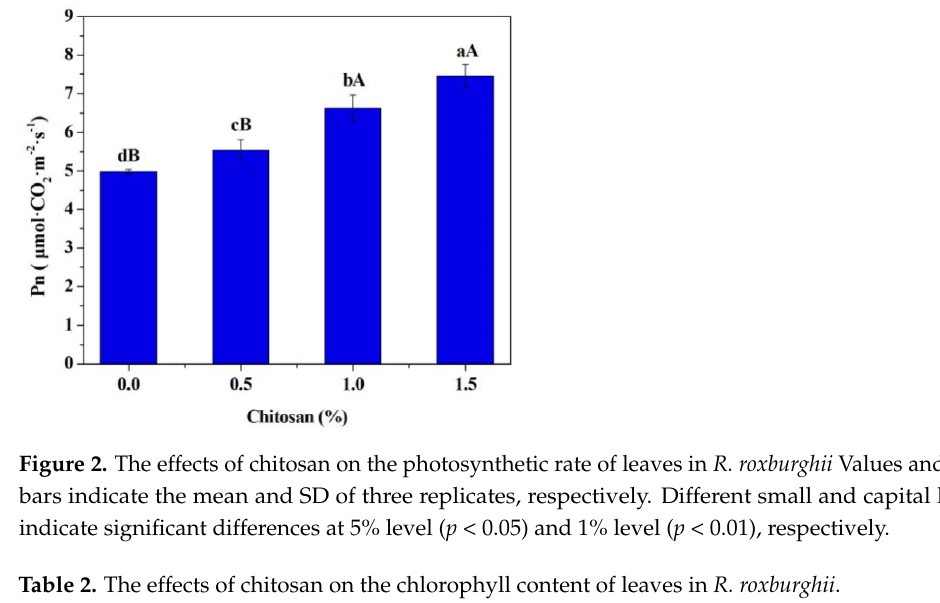
Table 2. The effects of chitosan on the chlorophyll content of leaves in R. roxburghii.